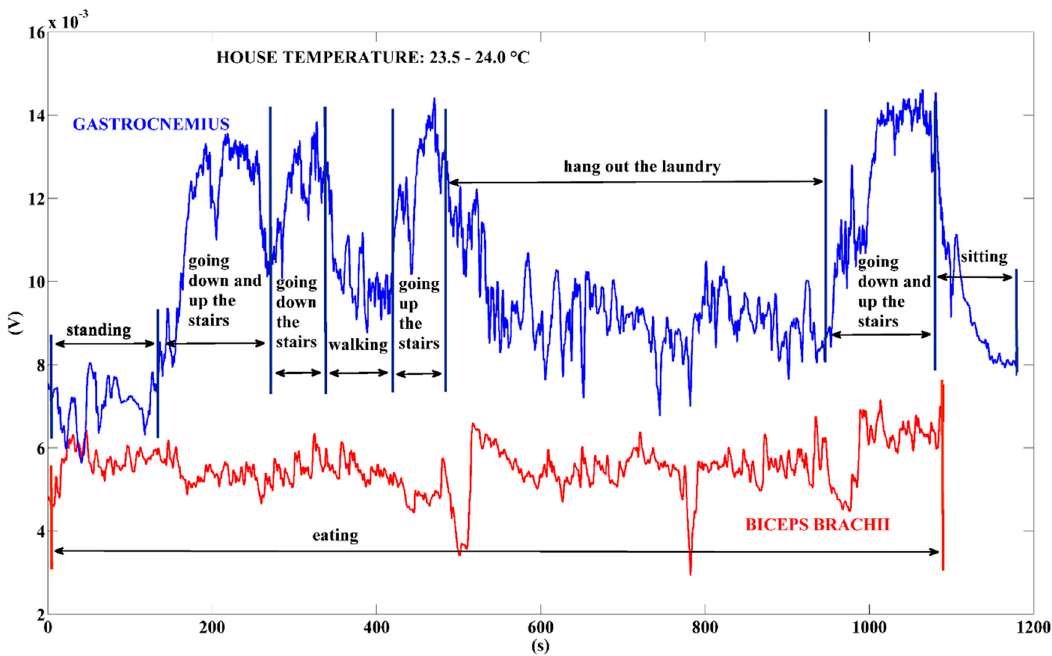
Figure 12. Voltage output signals generated by the TEG. The bold red line represents the voltage of the TEG placed on the biceps brachii while the user was eating; the bold blue line refers to the signal generated by the gastrocnemius muscle while the user was performing usual home activities. Time-interval: <1200 s.